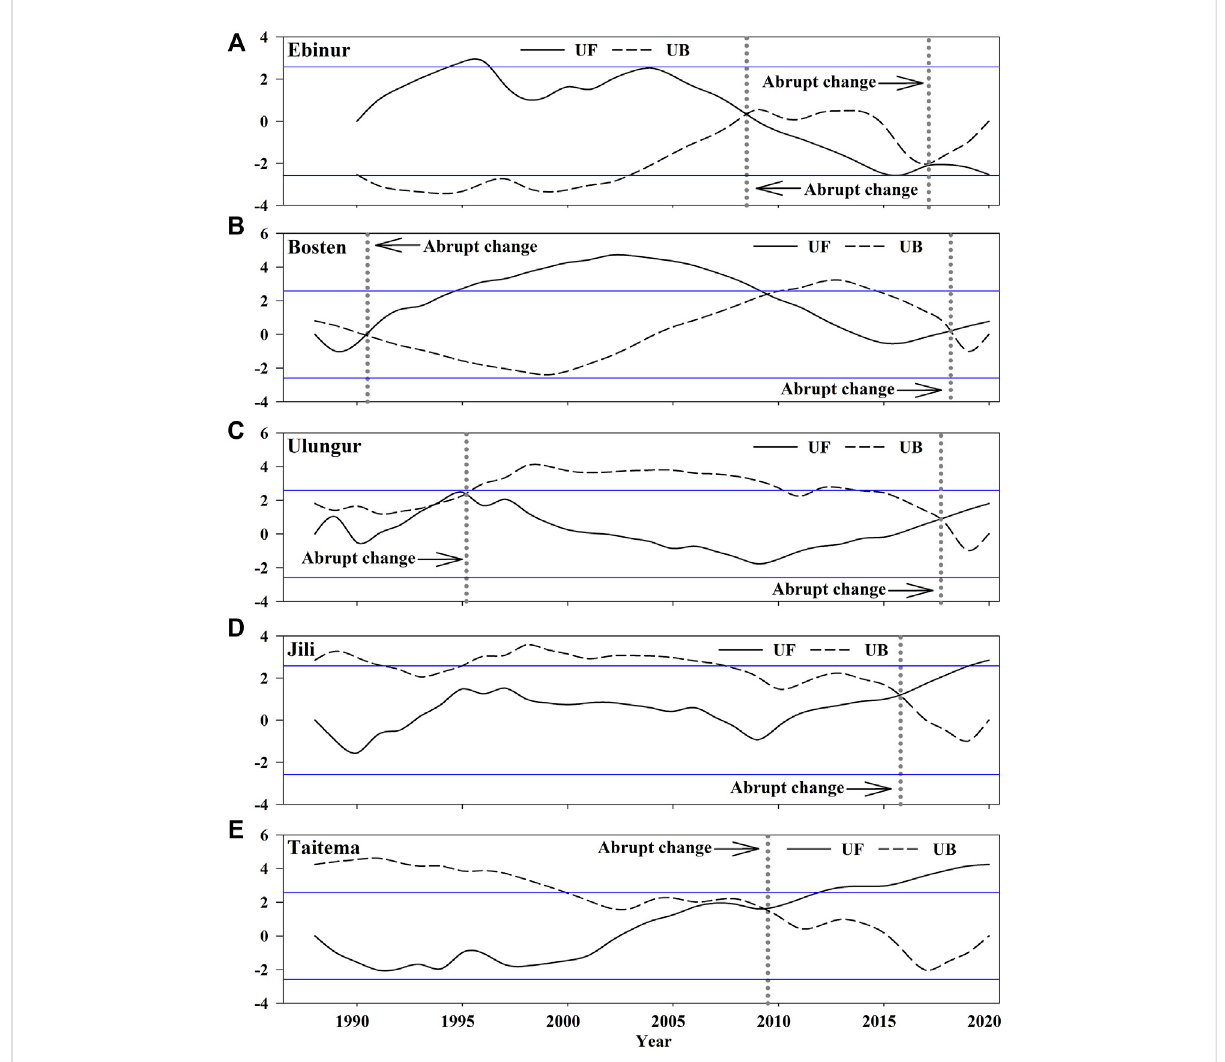
FIGURE 5 Results of the abrupt-change test of typical plains lakes area in Xinjiang from 1986 to 2020 (A) Lake Ebinure; (B) Lake Bosten; (C) Lake Ulungur; (D) Lake Jili; (E) Lake Taitema.